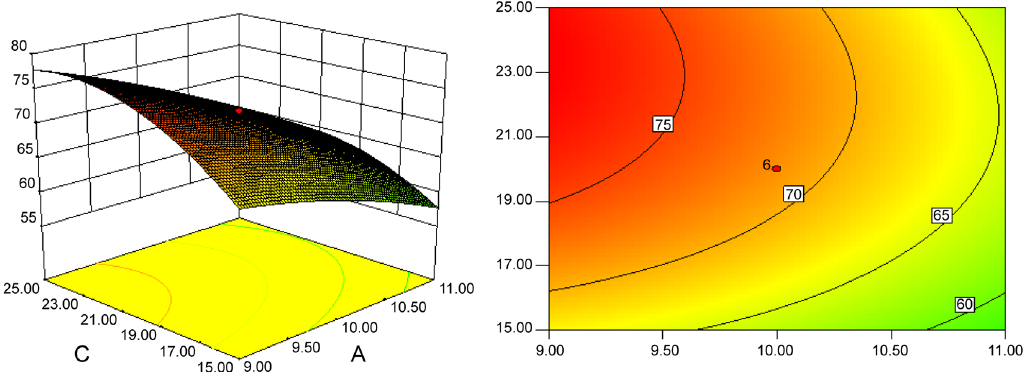
Figure 9: Response surface figure and contour map of sample solution pH value (A) and eluent volume (C). The range of A is from 9 to 11, and the range of C is from 15 to